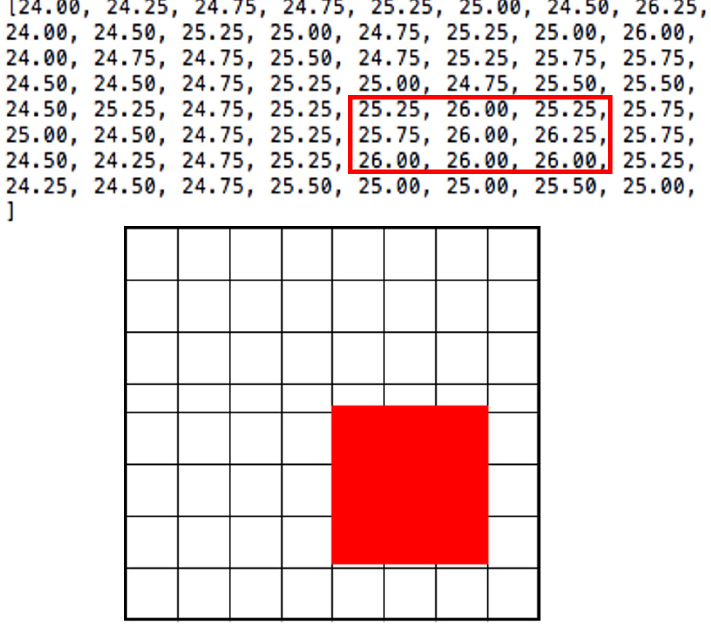
Figure 3. An example of skin temperature detection.